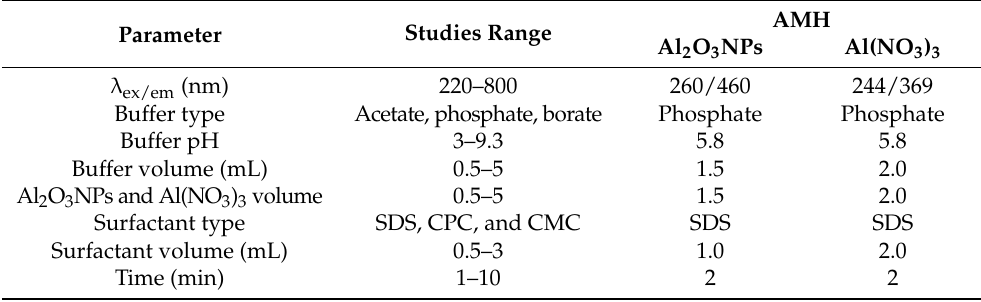
Table 1. Optimized conditions for the determination of AMH using the proposed